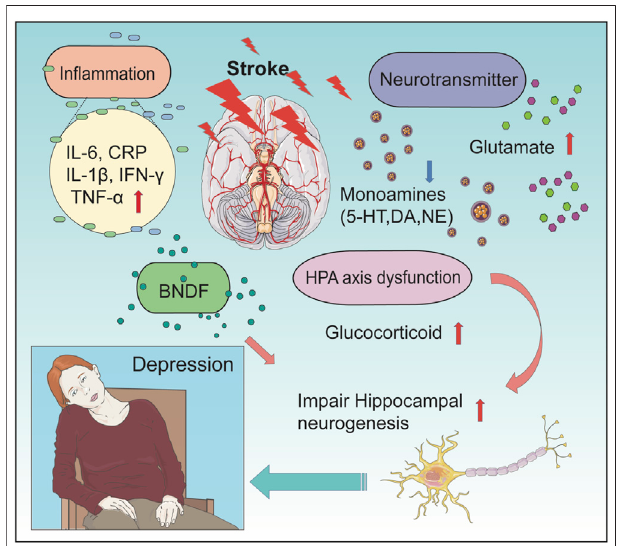
FIGURE 1 | Pathophysiological mechanisms of PSD. The picture shows theassociationofthemainpathophysiologicalmechanismsofPSD.Thereare four main mechanisms leading to PSD (including alterations in the neurotransmitter system, change in levels of in fl ammatory cytokine, dysfunction of the HPA axis, and in fl uence of neuroplasticity). After a stroke, alterations of the neurotransmitter system include deduced level of monoamines (5-HT, DA, and NE) and an increased level of glutamate. Changes in levels of in fl ammatory cytokine include an increased level of IL-6, CRP, IL-1 β , IFN- γ , and TNF- α . In PSD patients, the concentration of BNDF in the hippocampal was found to be decreased, which lead to impairment of hippocampal neurogenesis. At the same time, HPA axis dysfunction can lead to an increased concentration of glucocorticoid, which further impairs hippocampal neurogenesis. These changes can fi nally result in